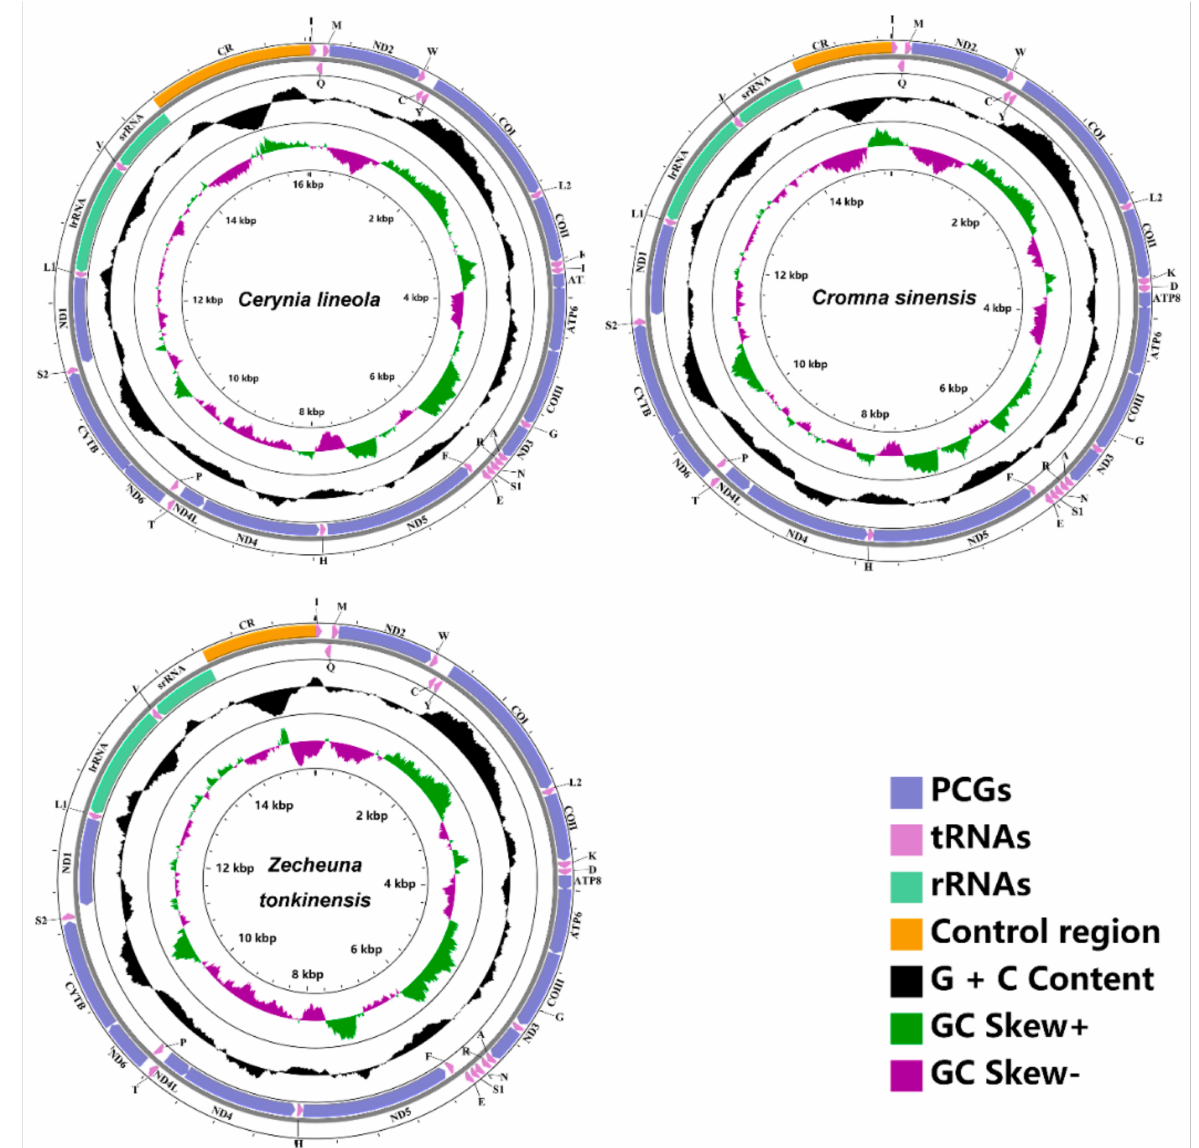
Figure 1. The mitogenomes of Cerynia lineola, Cromna sinensis and Zecheuna